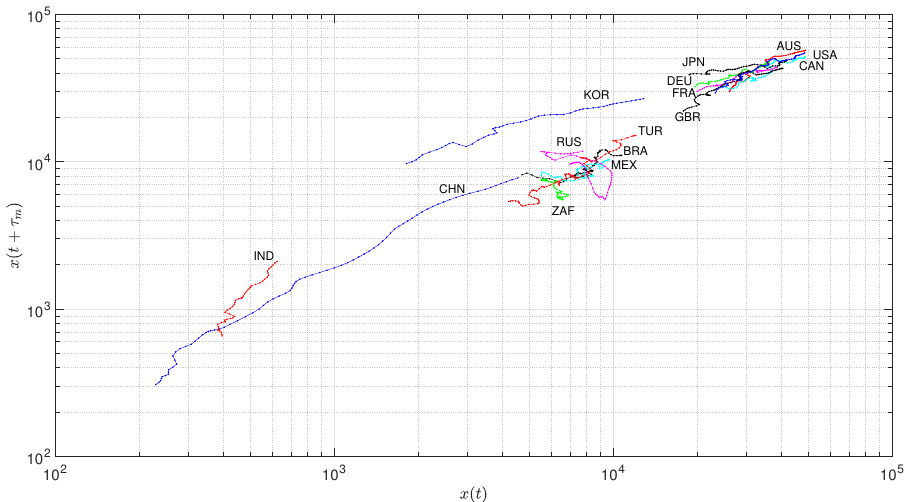
Figure 4. The pseudo-phase space (PPS) [ x ( t ) x ( t + τ m )] of GDP per capita for the set of 15 countries during 1970–2018.